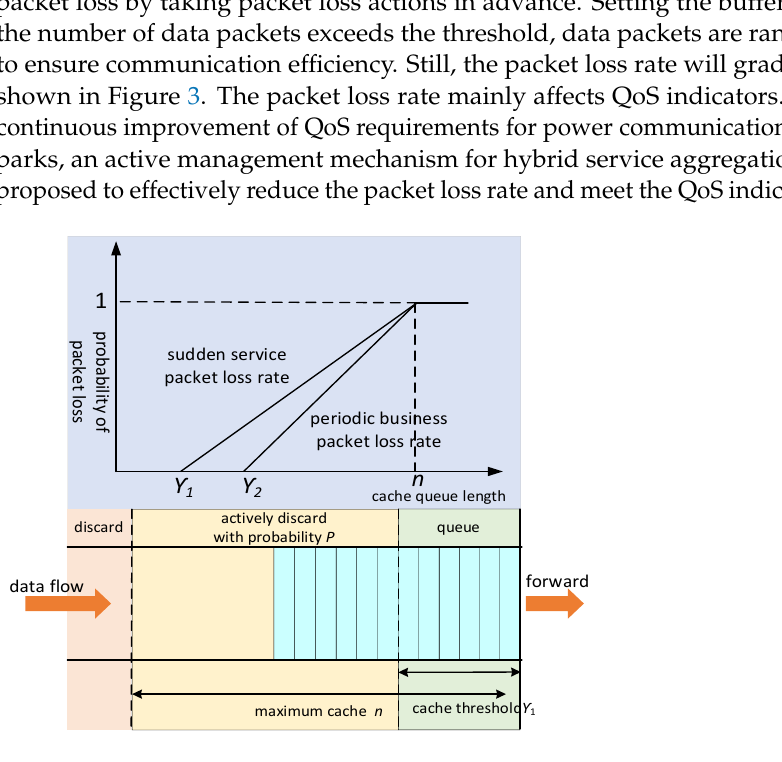
Figure 3. Active cache management mechanism of sink node for mixed services.